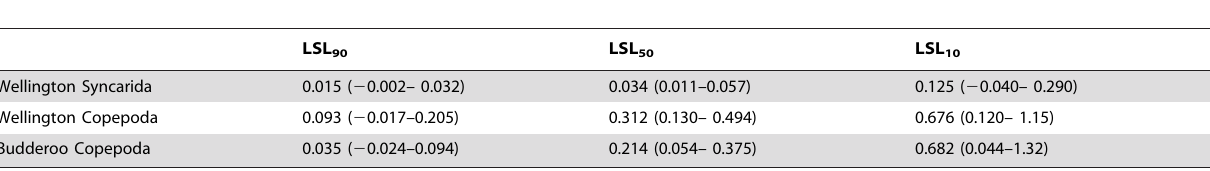
Table 1. Lethal saturation level values affecting 90, 50 and 10% of the